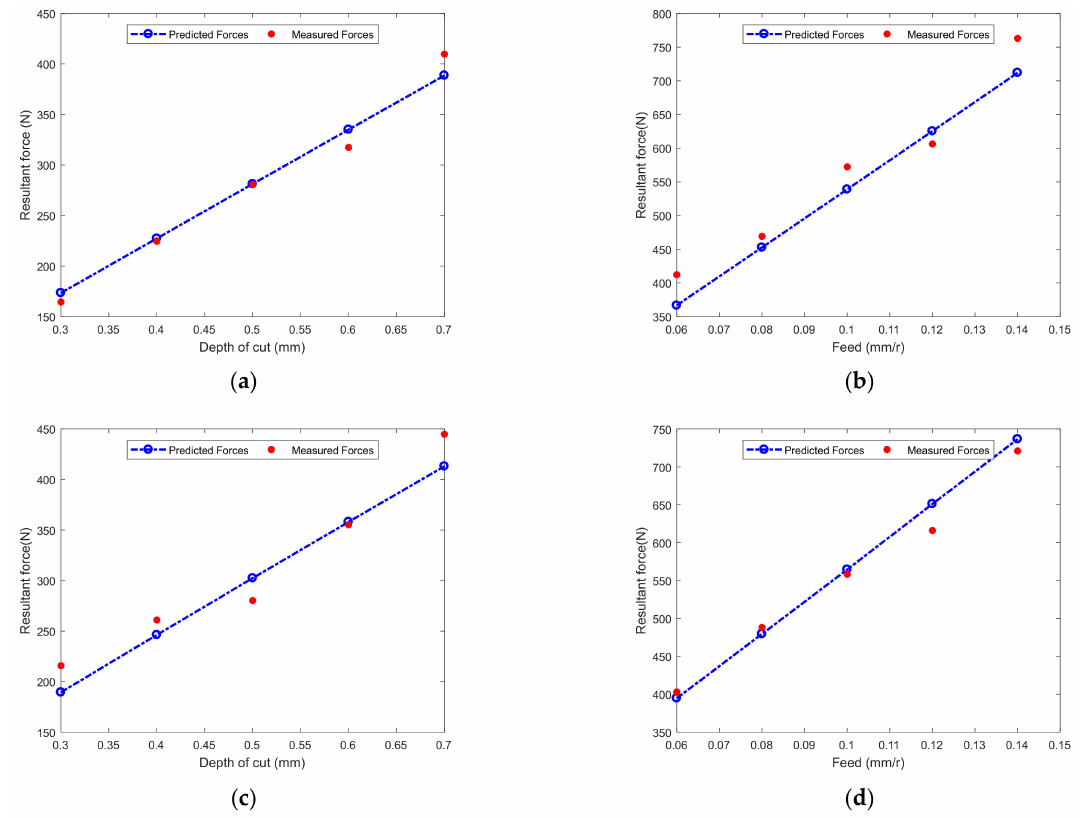
Figure 13. Comparison of measured and predicted cutting forces: ( a ) Tool No.1 and Tests 1–5, ( b ) Tool No.1 and Tests 6–10, ( c ) Tool No.2 and Tests 1–5, ( d ) Tool No.2 and Tests 6–10.